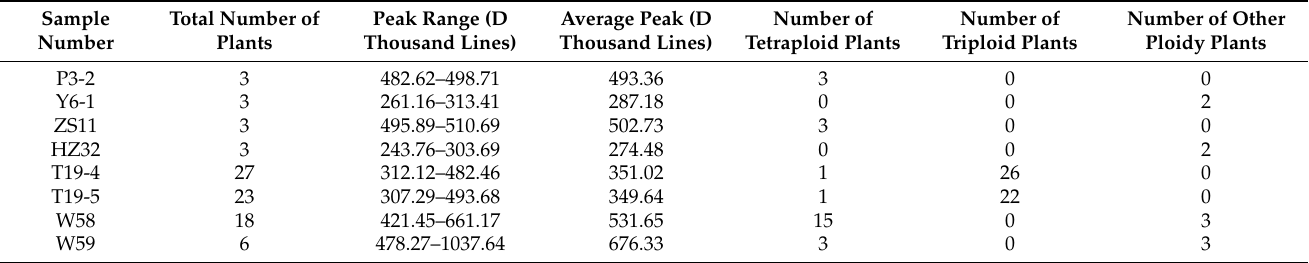
Table 2. Table of ploidy numbers and ranges of flow cytometry values for each